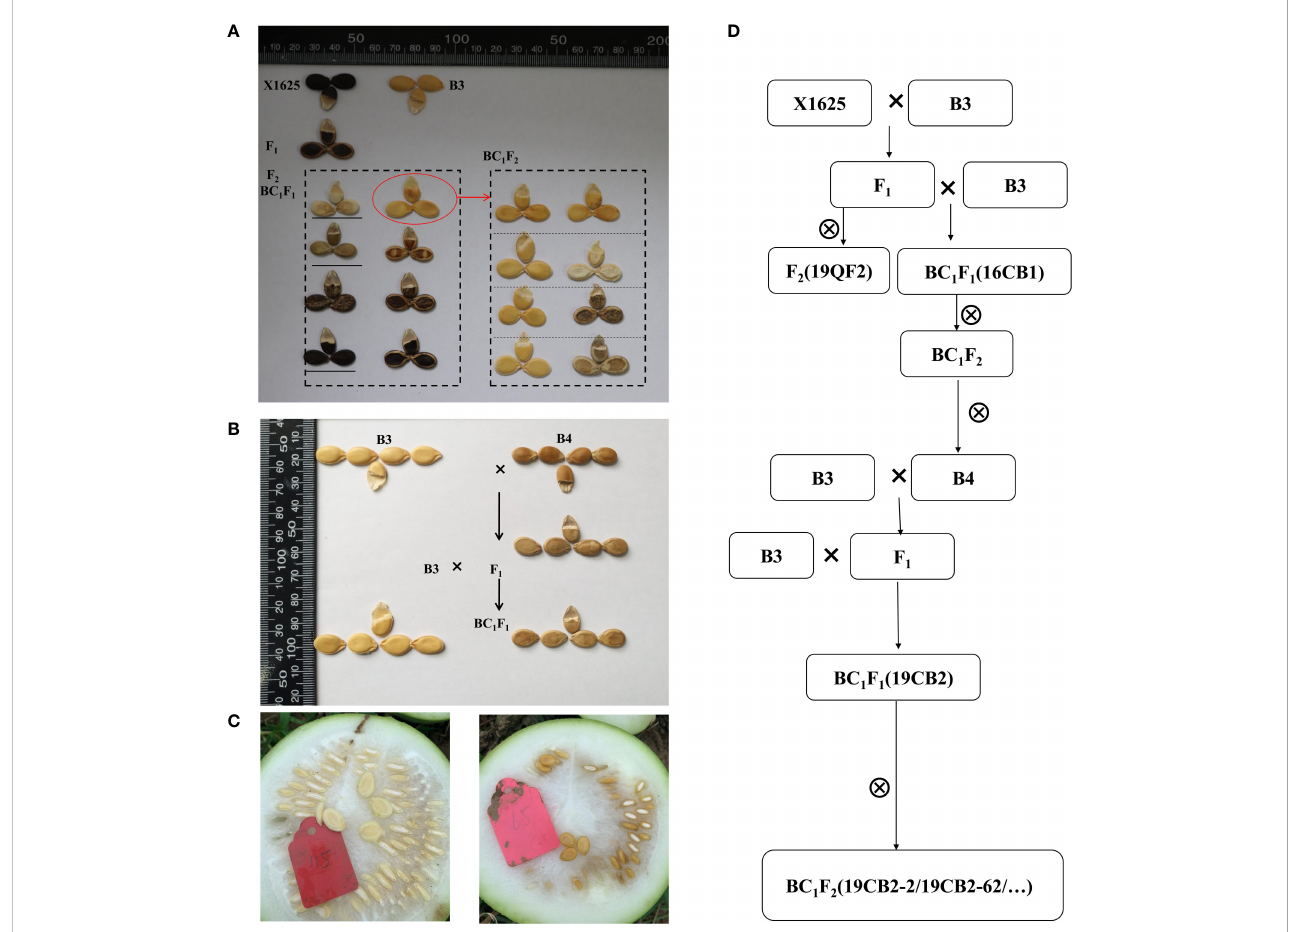
FIGURE 2 Seed types of the parents and progeny populations. (A) The seeds of B3, X1625, F 1 , F 2 , BC 1 F 1 , and partial BC 1 F 2 individuals after drying. (B) The seeds of B3, B4, F 1 , and BC 1 F 1 individuals after drying. (C) The fresh seeds of the egusi seed type (the same as B3, left) and non-egusi seed type (the same as B4, right). (D) The establishment process of the populations in the present